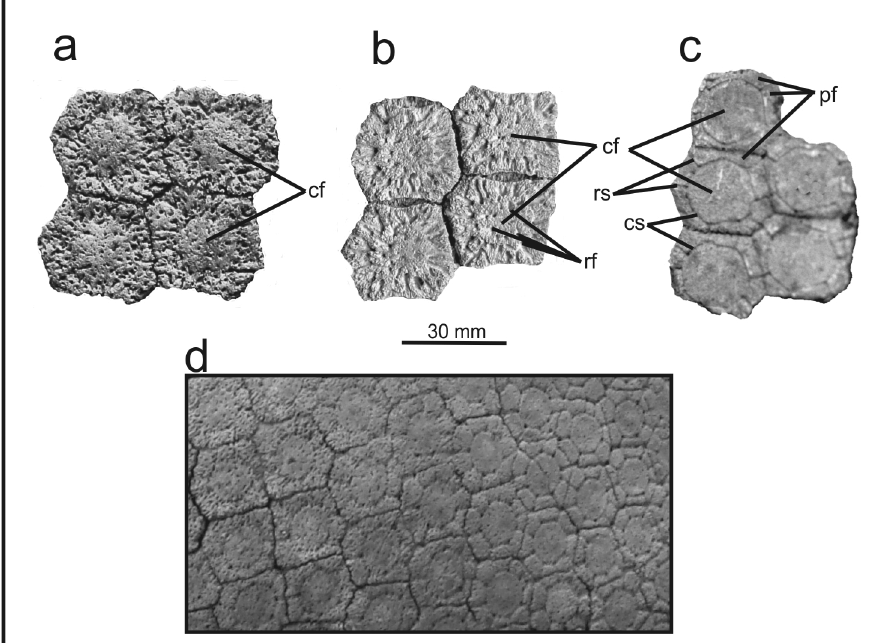
Figure 5 - Eosclerocalyptus . a (MMP 5303)- b (Xen 30). Osteoderms from the lateral region of the dorsal carapace showing the taphonomic alteration in the exposed exposed (= Lomaphorus / Urotherium / Trachychalyptus pattern); c (FM 05-266), lateral osteoderms showing the “rosette” ornamentation pattern; d , Eosclerocalyptus (Xen 30), detail of the lateral region of the dorsal carapace showing the alteration, from a real ornamentation pattern to a Urotherium / Lomaphorus / Trachycalyptus